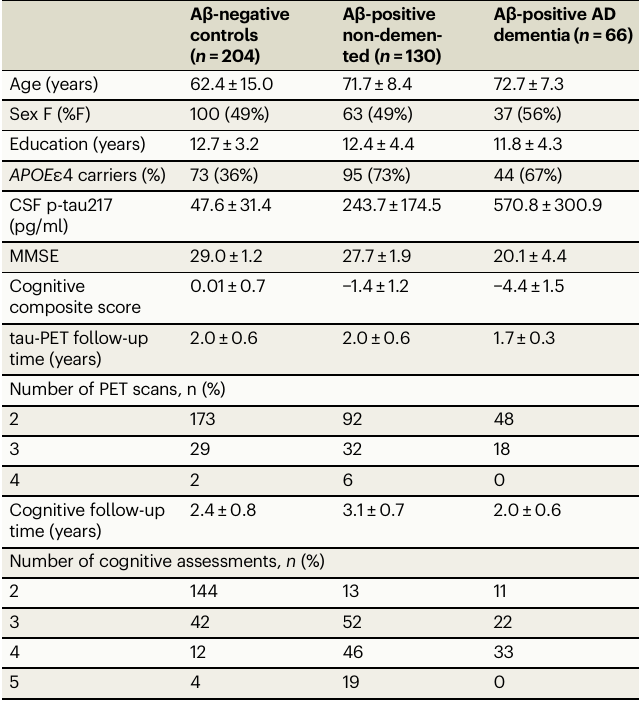
Table 1 | BioFINDER-2 cohort demographics A β -negative controls